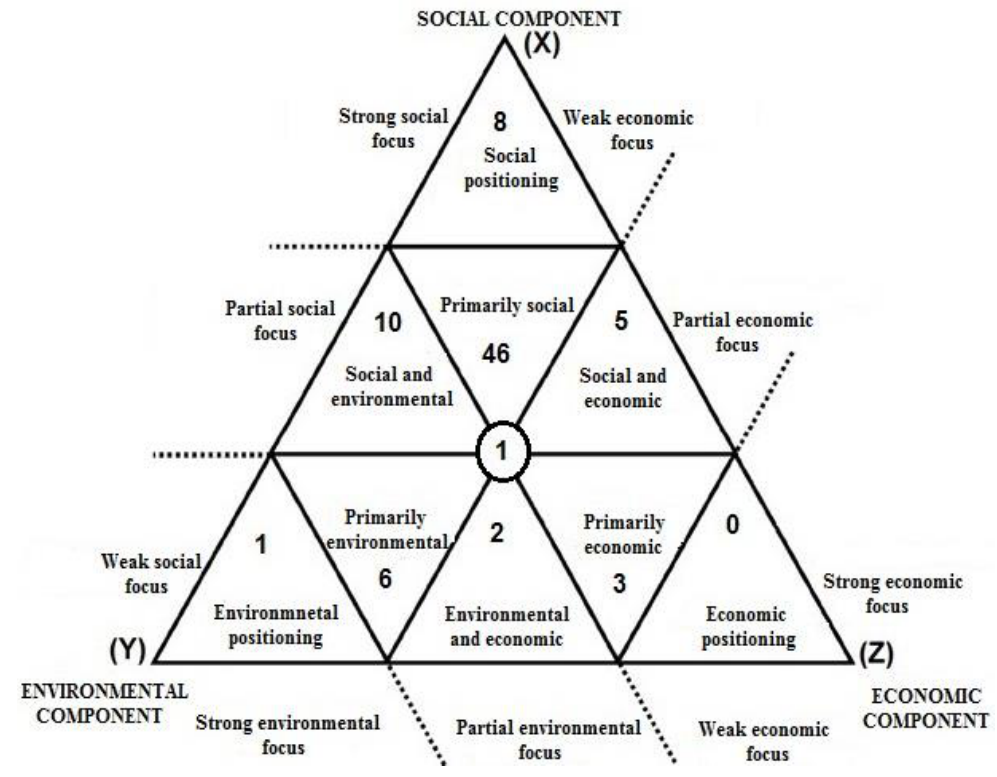
Figure 3. The Gibbs - Rosebom triangle of non-financial bank reporting in corporate social responsibility